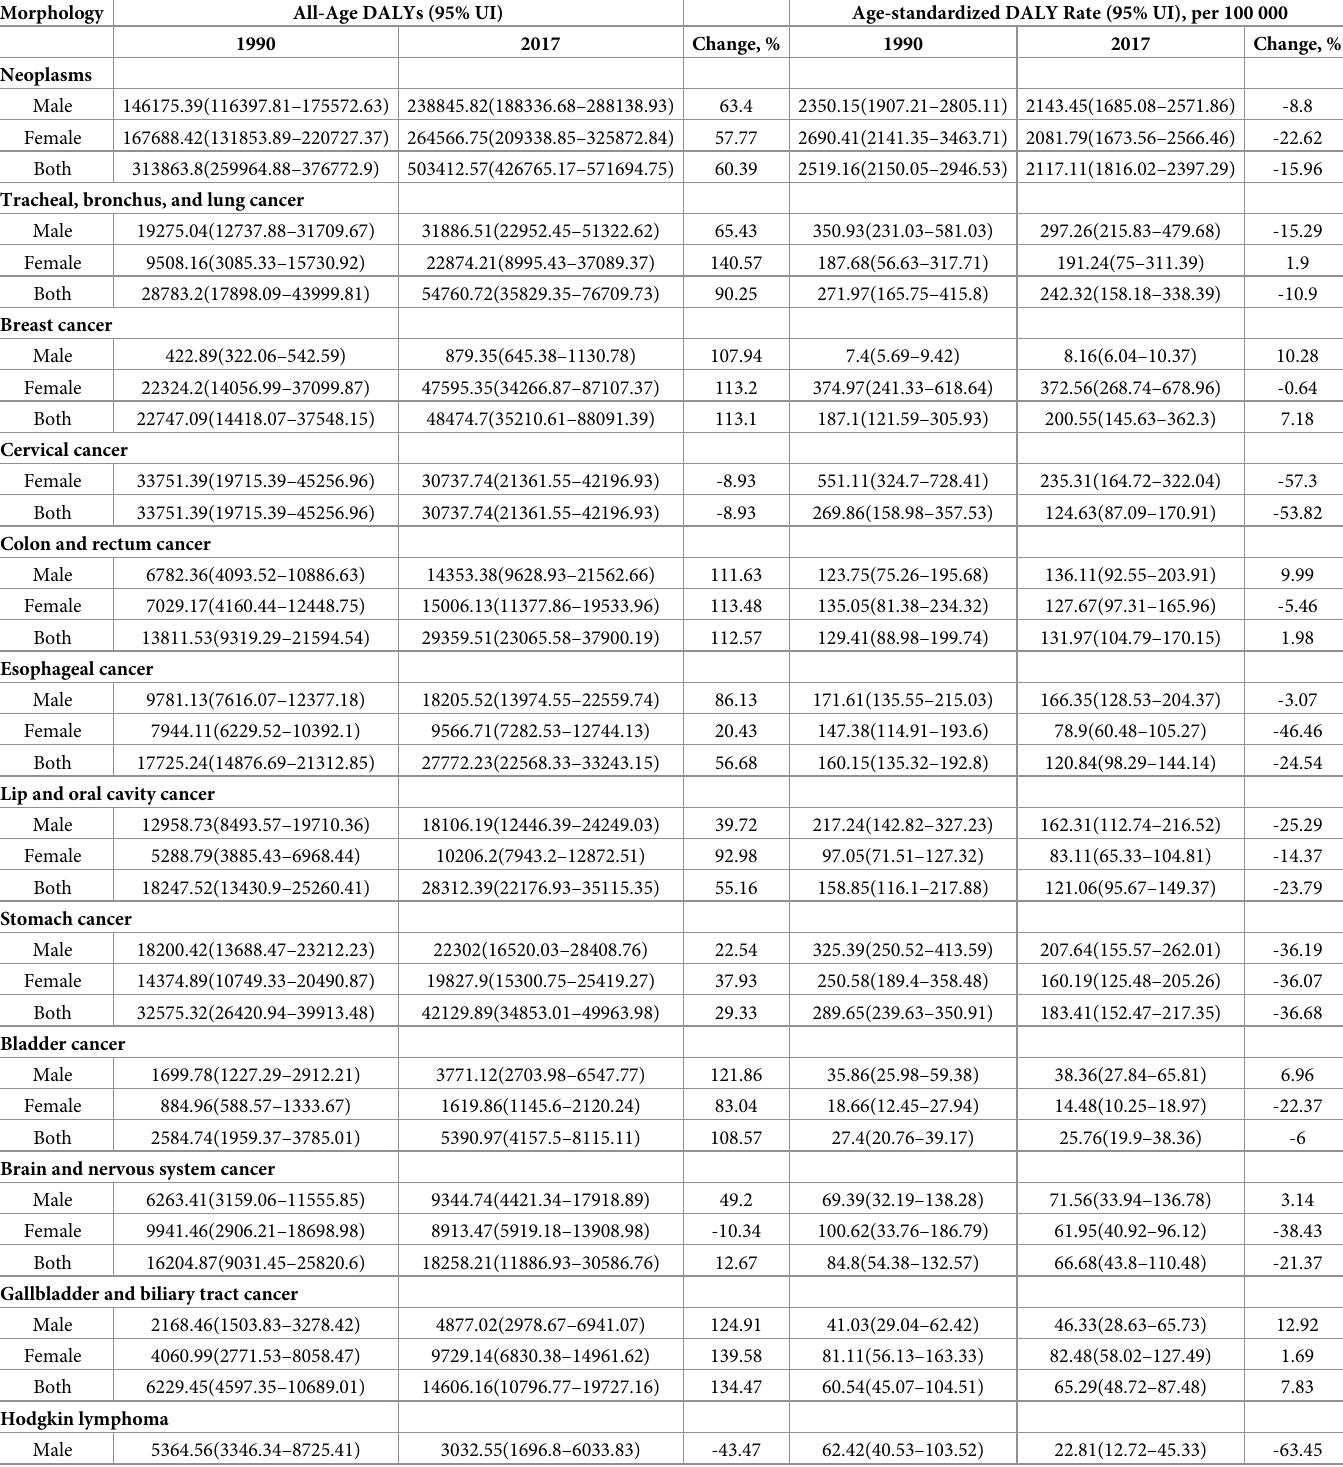
Table 5. All-age disability-adjusted life-years (DALYs) and age-standardized DALY rates for different types of cancer and their percentage change by gender in Nepal, 1990–2017.